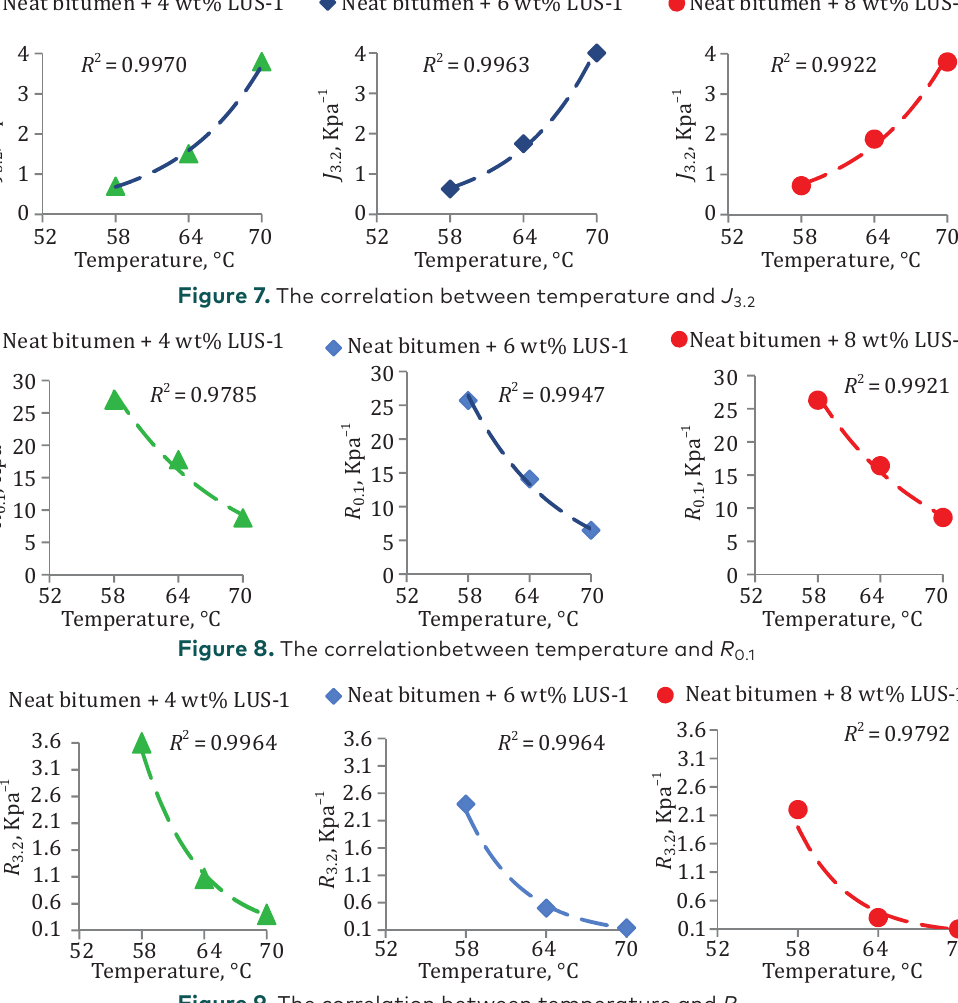
Figure 9. The correlation between temperature and R